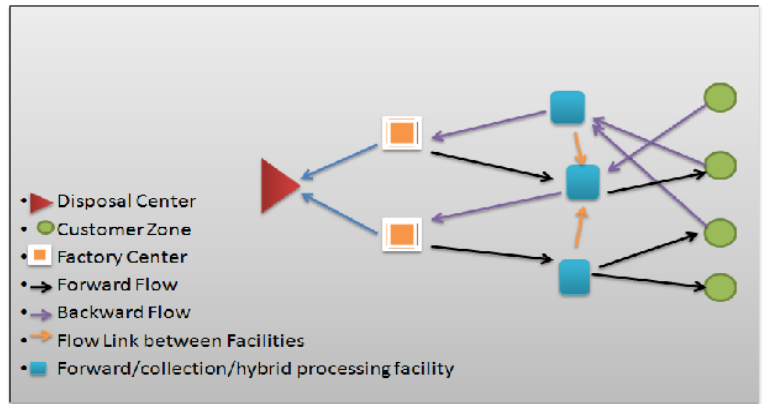
Fig. 1. The structure of the proposed